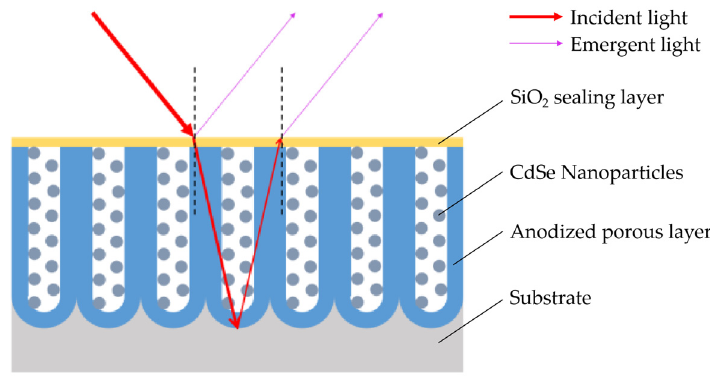
Figure 10. Diagram of light absorption in the film system.